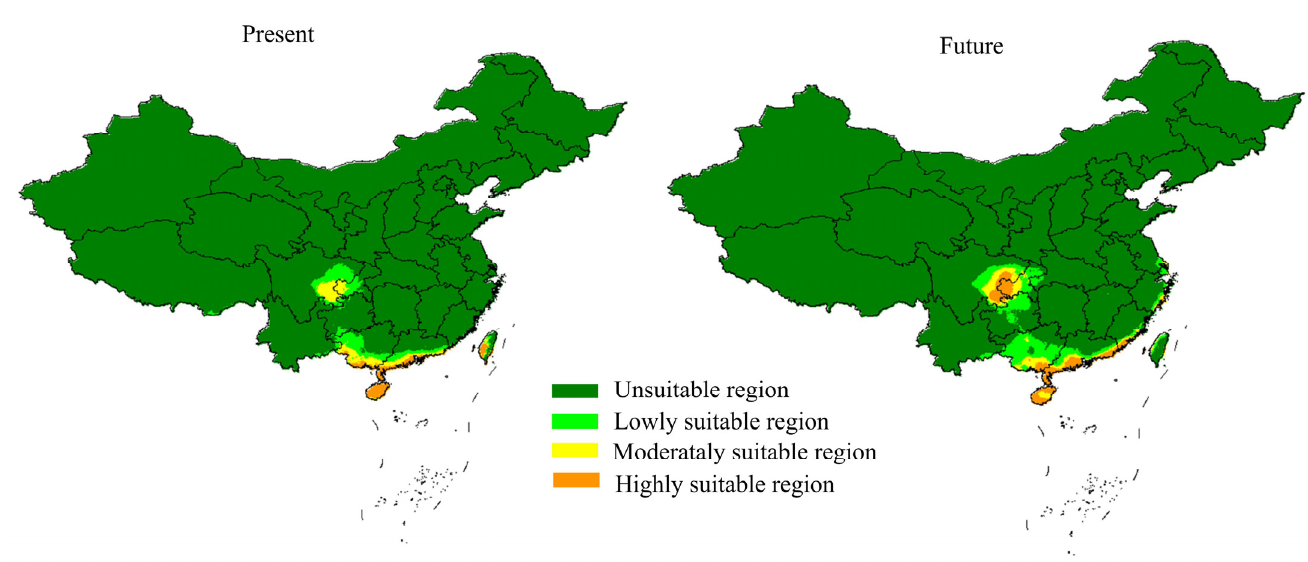
Figure 8. Potential distribution areas of S. parviflora in the current and future periods.